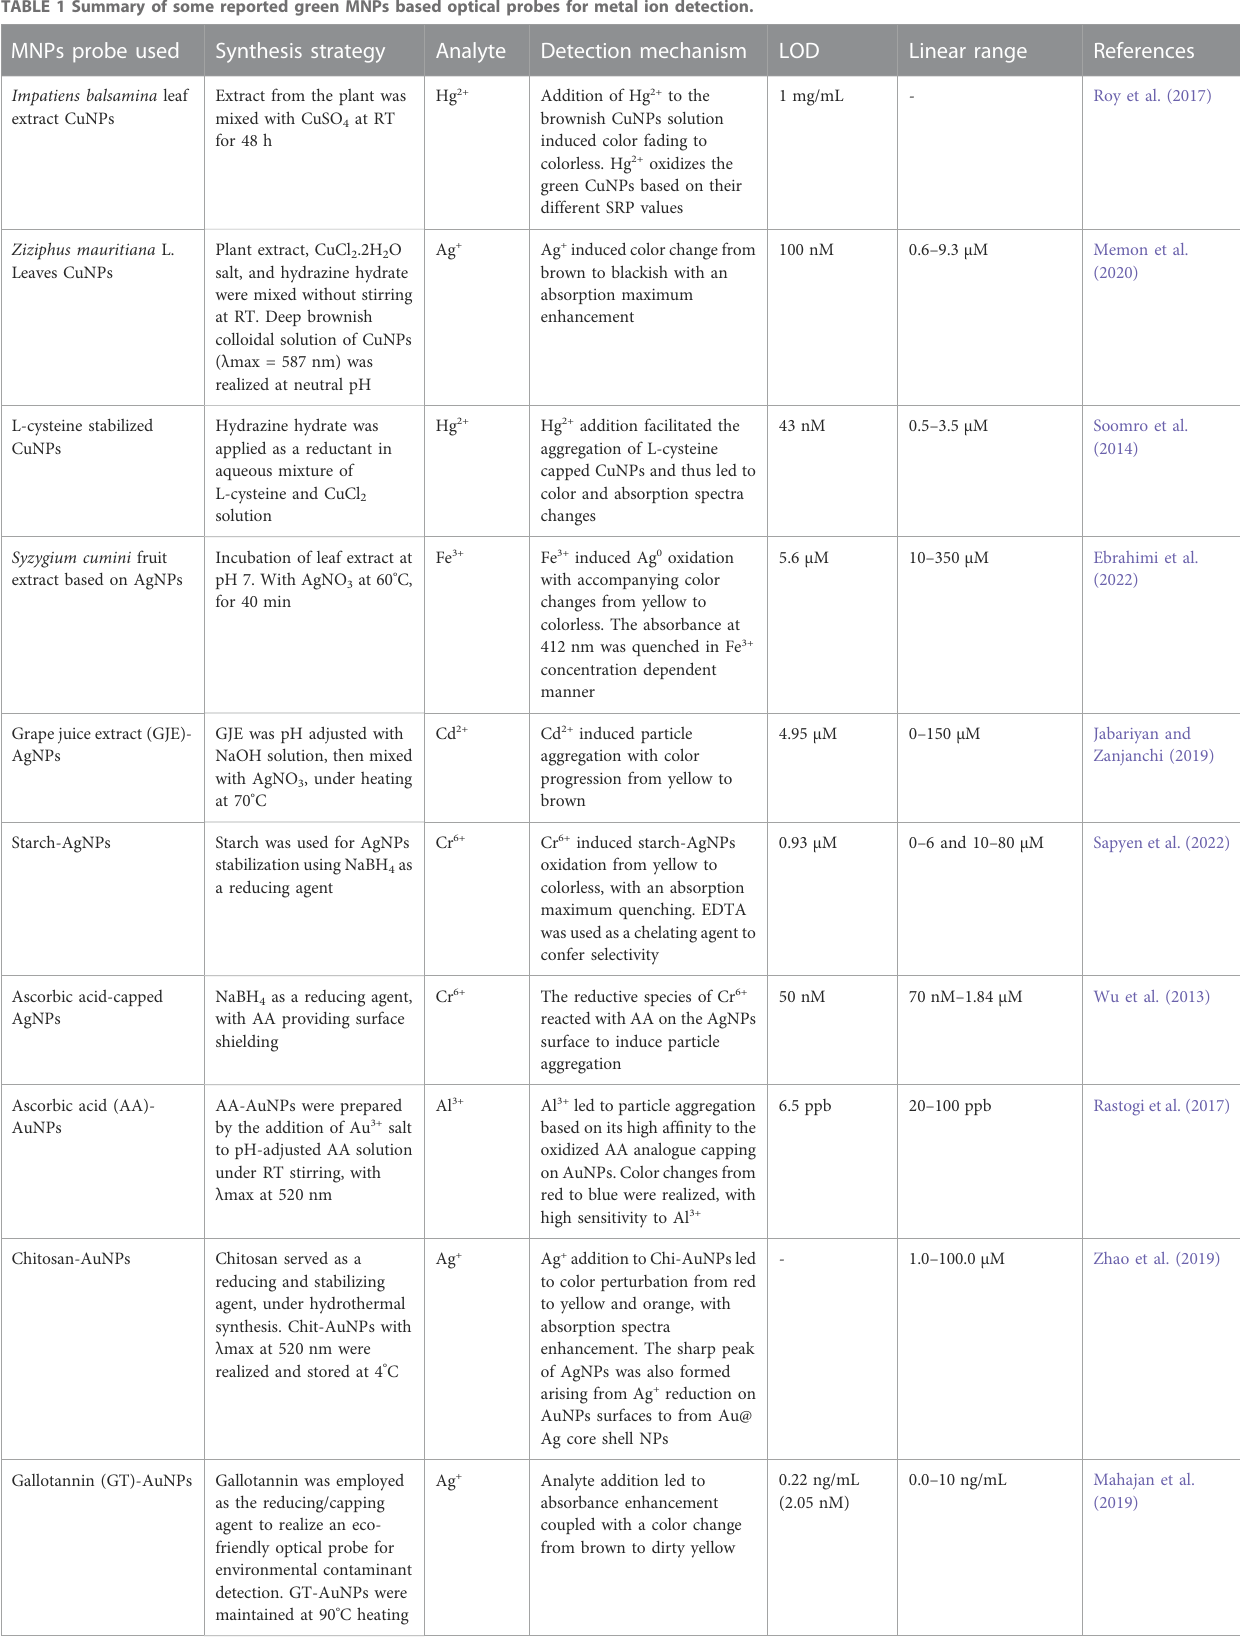
TABLE 1 Summary of some reported green MNPs based optical probes for metal ion